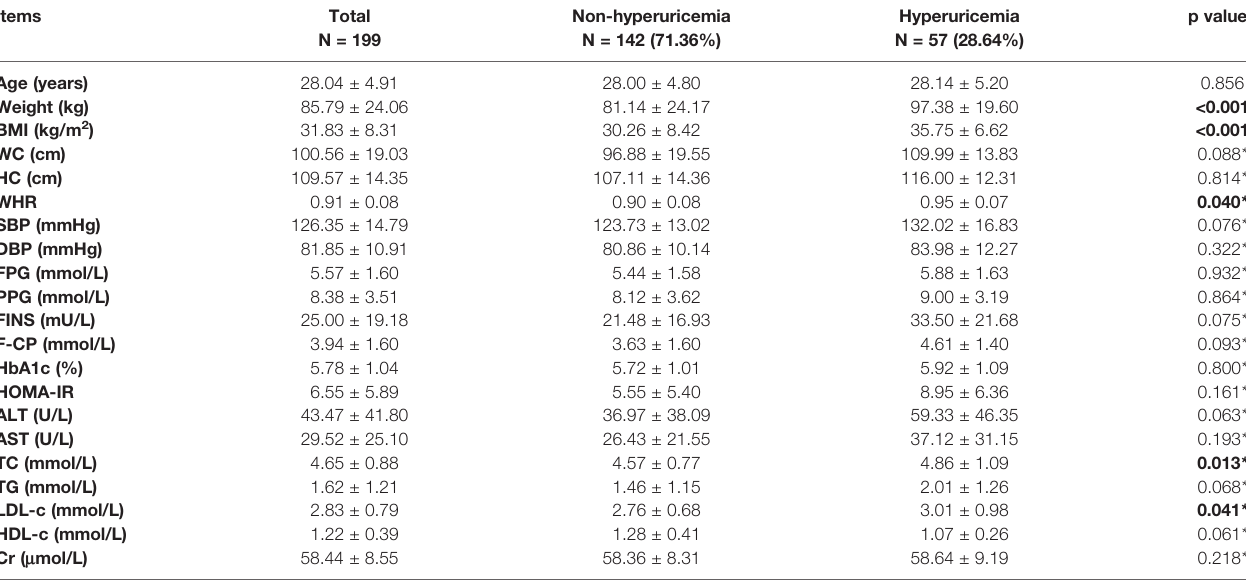
TABLE 2 | Anthropometric and metabolic characteristics of the patients with PCOS in total, non-hyperuricemia group and hyperuricemia group. Items